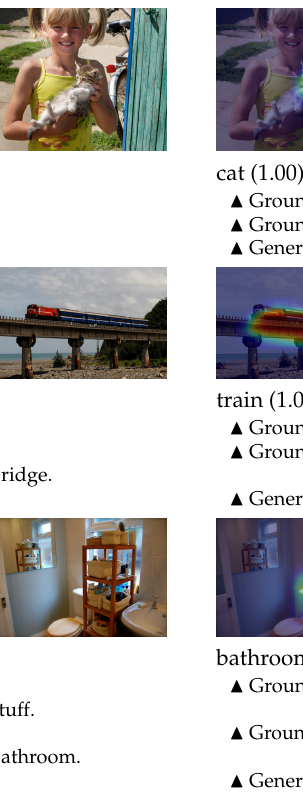
Figure 6. The visualization of the localization heat maps from the proposed RUDet, and the generated captions from the RUDet plus Multimodal Attribute Detector plus Subsequent Attribute Predictor (RUDet+MAD+SAP). The first column shows the original images. The following columns are the heat maps indicating the probabilities of major words using class activation mapping (CAM) [34], where red regions denote higher probabilities, and blue regions denote lower probabilities. The sen- tences below show the ground truth captions and the generated